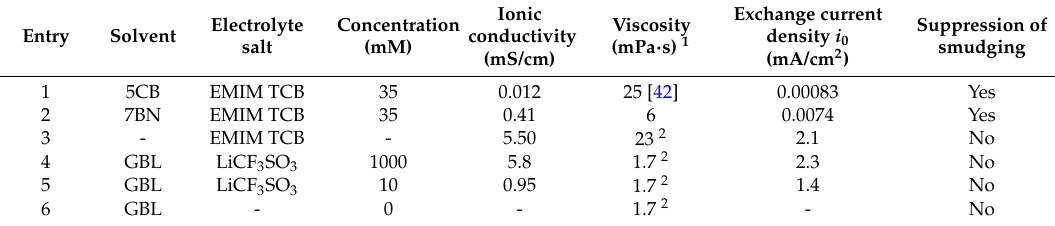
Table 2. Electrochemical parameters for electrolytes solution and thin layer electrodes of 1 .